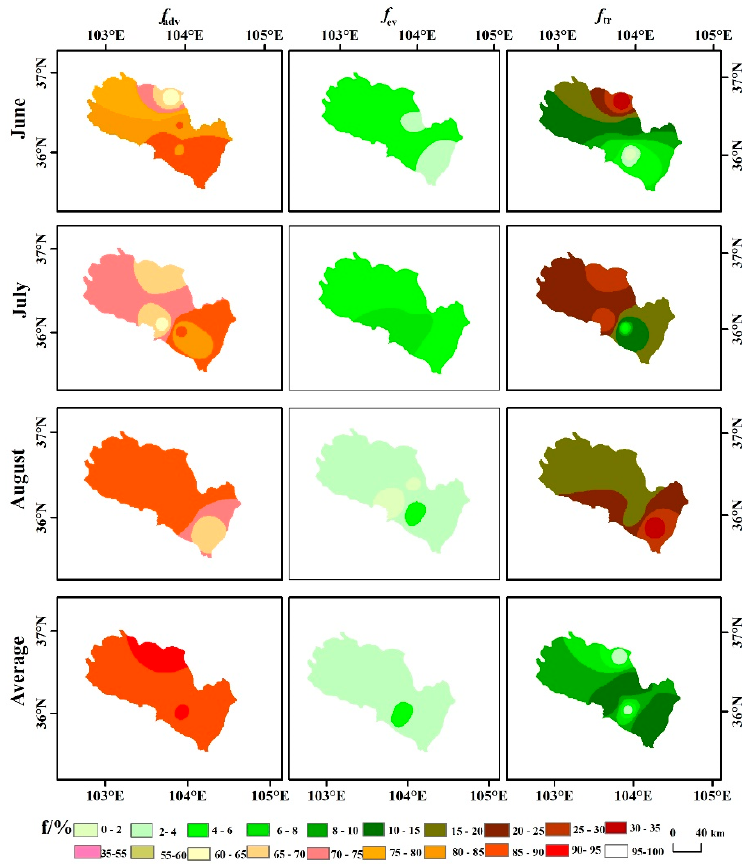
Figure 3. Spatial distribution of proportional contribution of each water vapor fluxes to precipitation in Lanzhou city.